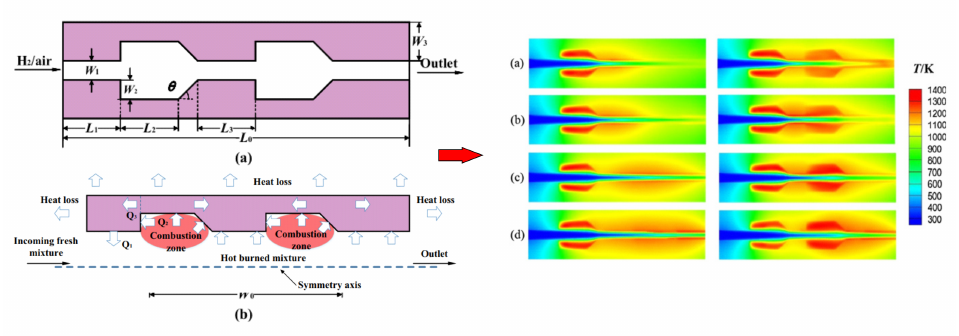
Figure 16. Design features of the micro combustor and the temperature field. ( a ) Design features of combustor, ( b ) Temperature field of the